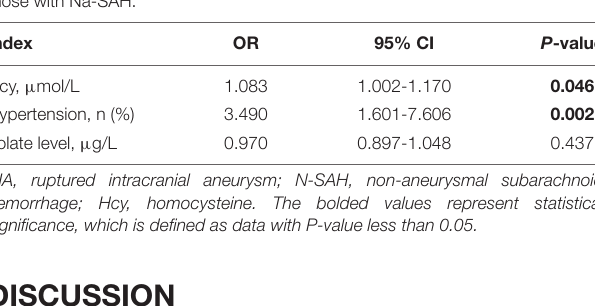
associated with the RIA (OR 1.069; 95% CI 1.025–1.114, p = 0.002) after adjusting for confounders ( Table 2 ).